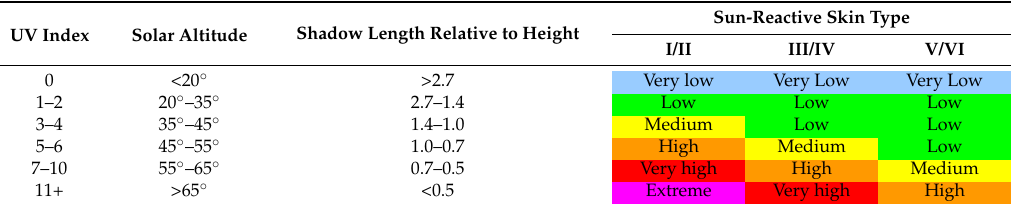
Table 1. The risk of sunburn and skin damage as a function of UV index for different skin types, together with the approximate range of solar altitudes and shadow lengths corresponding to the UV